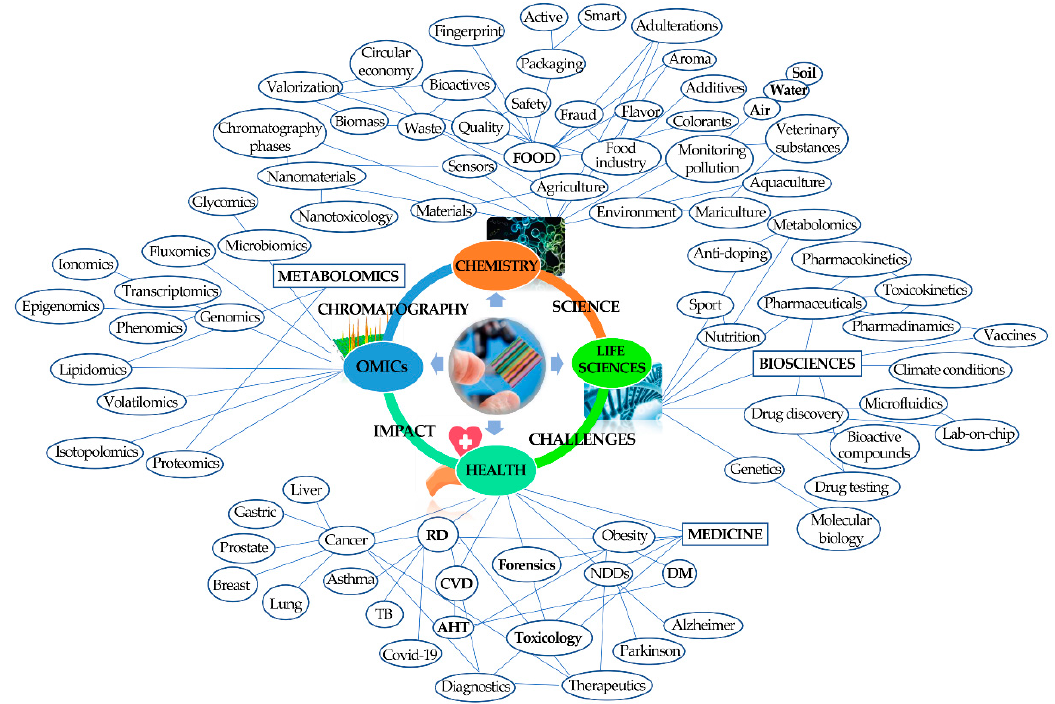
Figure 5. Co-occurrence network map related to the importance of chromatography in some fields of science.